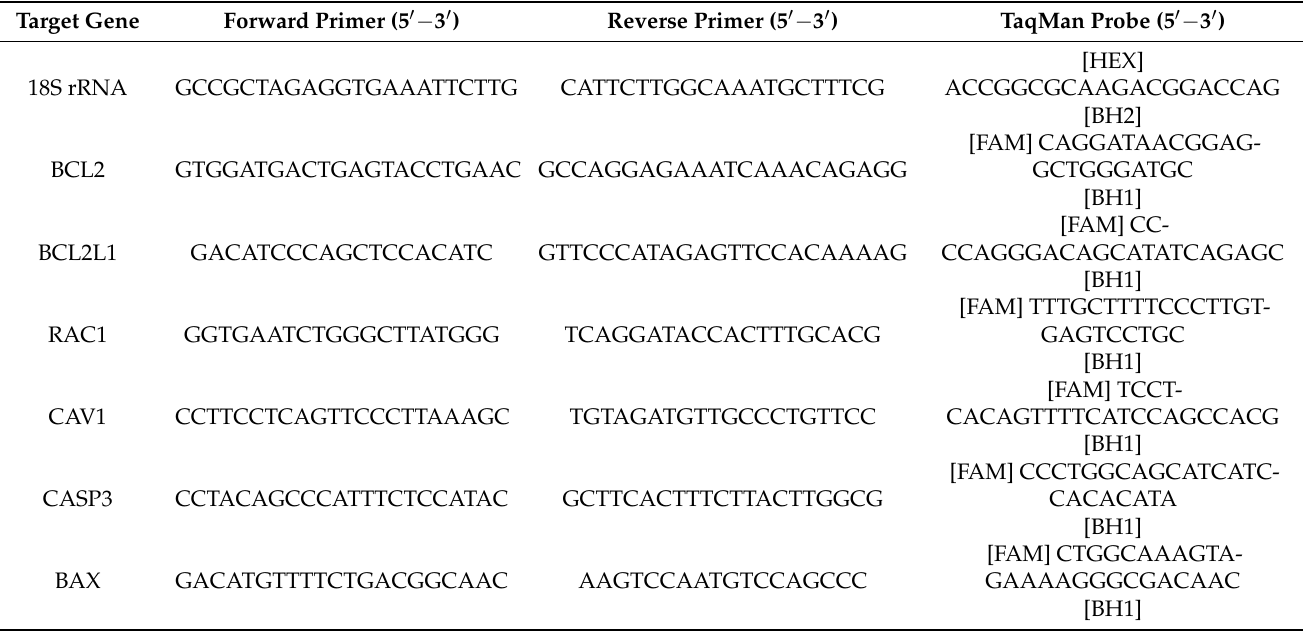
Table 1. Primer and probe sequences of related genes for